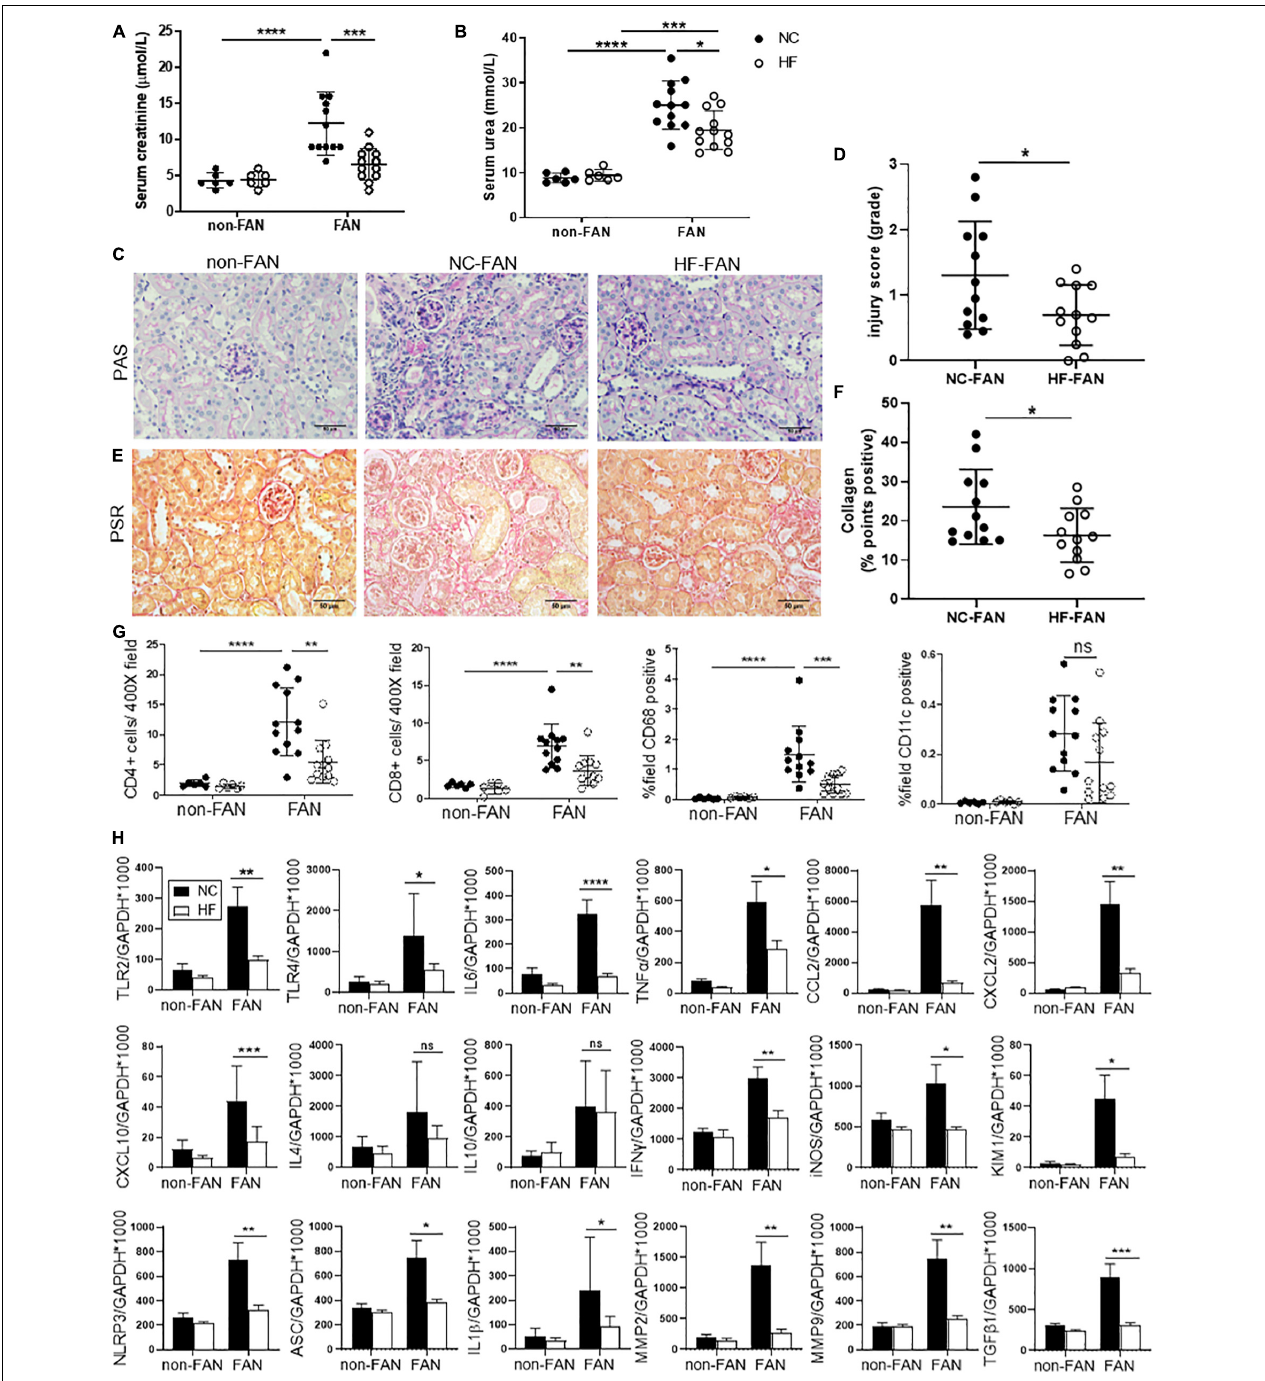
FIGURE 2 | HF fed mice exhibit less chronic inflammation at day 28 after FAN induced AKI. HF fed mice developed less chronic kidney injury at day 28 following FA-induced AKI, with lower serum creatinine (A) , BUN (B) and histological injury scores assessed on PAS stained kidney sections (C,D) compared to NC fed FAN controls. Representative sections of kidney from FAN and non-FAN mice at day 28 demonstrating increased interstitial collagen deposition attenuated by HF feeding on PSR staining (E,F) . Quantification of immunostaining for CD4 + and CD8 + T cells, CD68 + macrophages and CD11c + dendritic cells demonstrates significant infiltration in NC fed FAN kidneys. HF feeding significantly diminished T cell and CD68 + macrophage accumulation in FAN kidneys, with a trend toward diminished CD11c + infiltrate (G) . (H) mRNA expression of innate immune receptors (TLR2 and TLR4), pro-inflammatory cytokines (TNF α , IL6, and IFN γ ), chemokines (CCL2, CXCL2, and CXCL10), inflammatory mediator (iNOS), inflammasome components (NLRP3, ASC, and IL1 β ), renal proximal tubular injury marker (KIM1), and fibrosis related genes (TGF β 1, MMP2, and MMP9) were significantly reduced in HF fed FAN mice as compared to NC fed FAN controls. No significant difference was seen in Th2 cytokines (IL4 and IL10) following HF feeding. NC, vehicle ( n = 6); HF, vehicle ( n = 6); NC, FAN ( n = 12); HF, FAN ( n = 12). Photomicrographs at 400 × , scale bar 50 µ m. Data are shown as means ± SD or mean ± SEM; * P < 0.05, ** P < 0.01, *** P < 0.001, **** P < 0.0001.